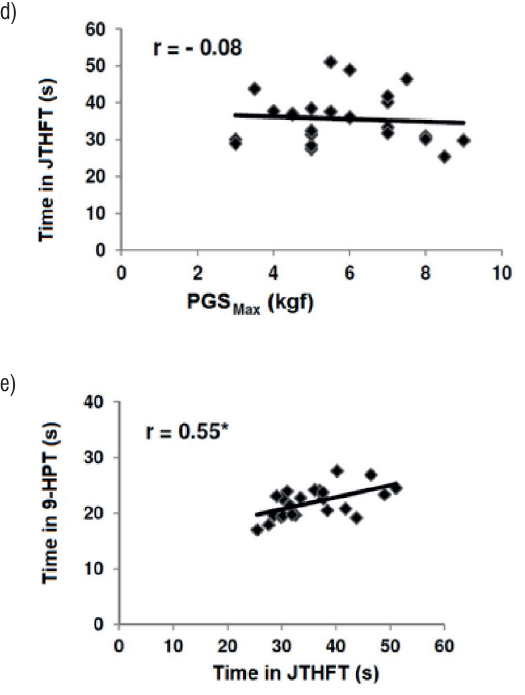
Figure 1 - Relationship between the performance variables in 9-HPT, JTHFT tests and HGSMax and PGSMax. Pearson’s correla- tion coefficients are presented for each relationship, and the asterisk represents statistically significant